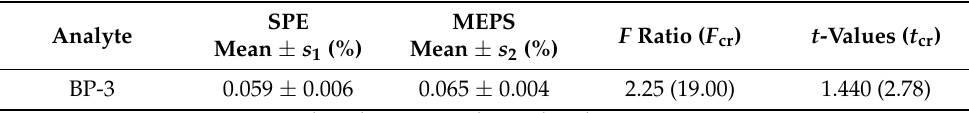
Table 4. Statistical comparison between the two techniques by Snedecor F -test and Student- t test; determination of BP-3 content in hair mask sample.